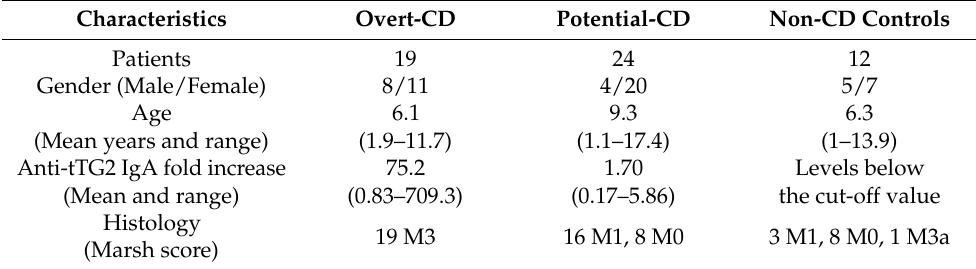
Table 1. Clinical features of Caucasian pediatric subjects enrolled in the